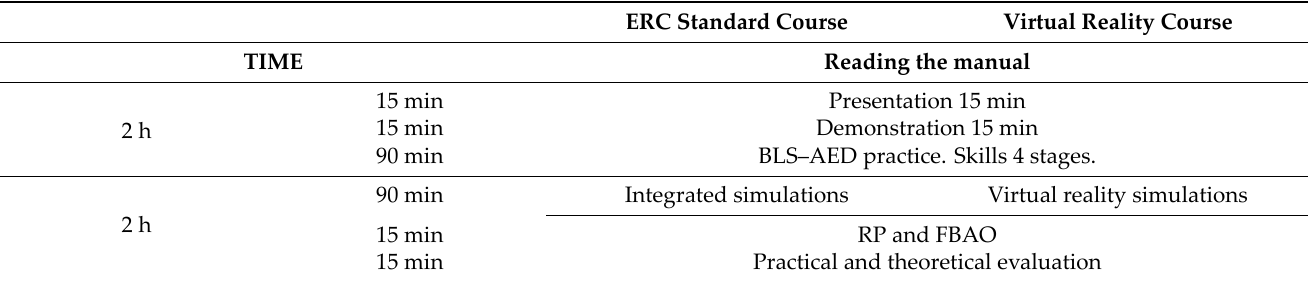
Table 1. Training in traditional BLS–AED or with virtual reality. ERC Standard Course Virtual Reality Course TIME Reading the manual 15 min Presentation 15 min Demonstration 15 min BLS–AED practice. Skills 4 stages. 90 min Integrated simulations Virtual reality simulations RP and FBAO 15 min Practical and theoretical